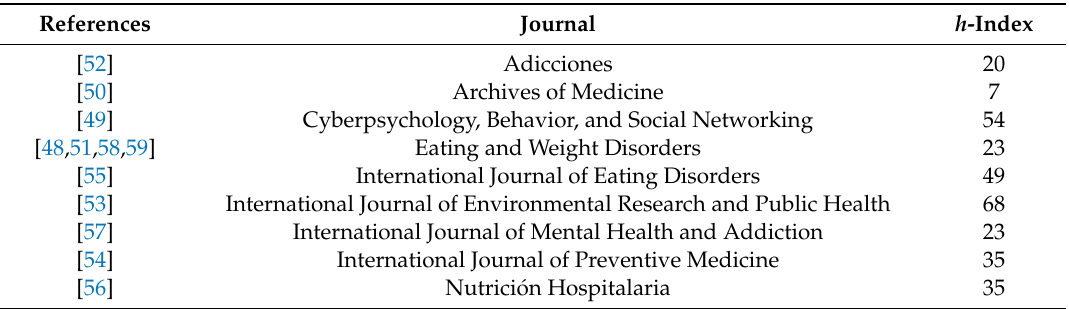
Table 2. Source title and h -index.